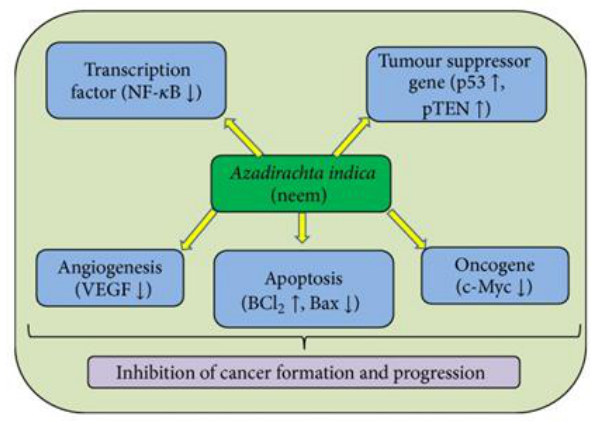
Figure 6 : Anticancer activity of Azadirachtaindica (neem) through the modulation of various signals pathways [16].